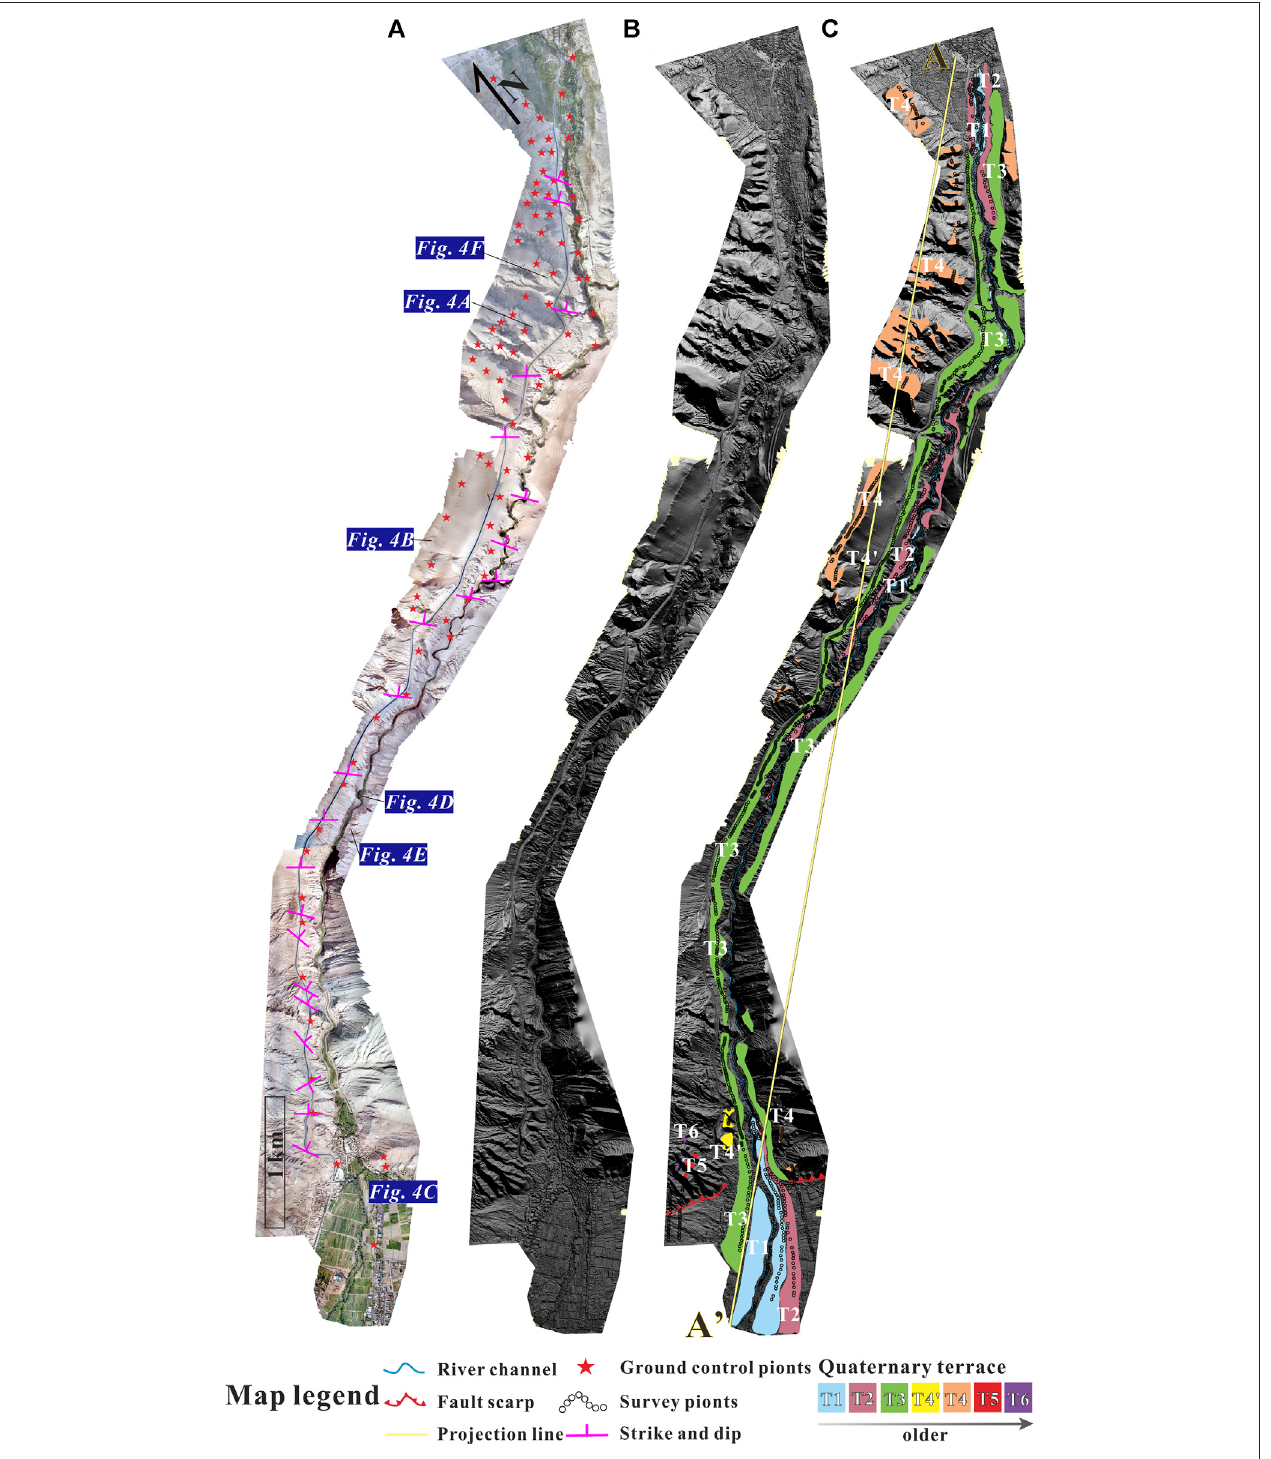
FIGURE3|(A) OrthographyimagesoftheTuyugouValley(see Figure2A forthelocation).RedstarsshowthelocationsofGPSsurveygroundcontrolpoints,and pink symbols indicate the locations and orientations of structural measurements. (B) Digital elevation model (DEM) surveyed by an unmanned aerial vehicle. (C) Geomorphic mapping of terraces in the Tuyugou Valley. Colours and numbers indicate the six generations of terraces (T4 ’ represents a secondary terrace of T4), black dots show the individual points on terraces and river channels that are projected onto line A-A ’ .